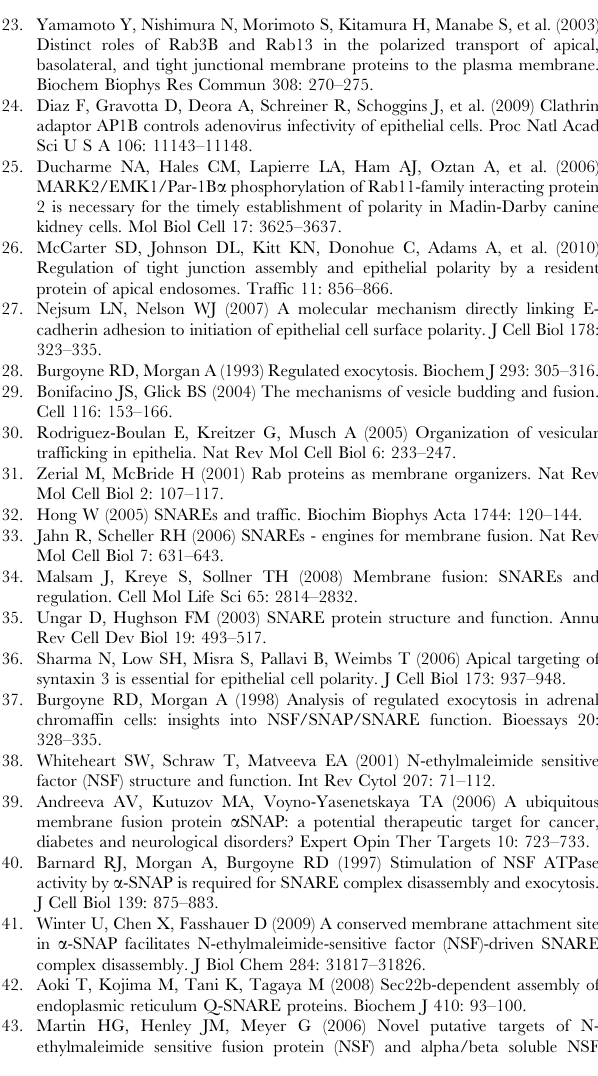
IgG, confirms the specificity of b 1 integrin staining. Scale bar, 20 m m. (TIF) Figure S4 Downregulation of BIG1 and BIG2 expression does not affect the integrity of epithelial apical junc- tions. Immunofluorescence labeling shows normal architecture of b -catenin-based AJs and occludin/ZO-1-based TJs in either BIG1 or BIG2-depleted SK-CO15 cells on day 4 post-transfection. Scale bar, 20 m m.